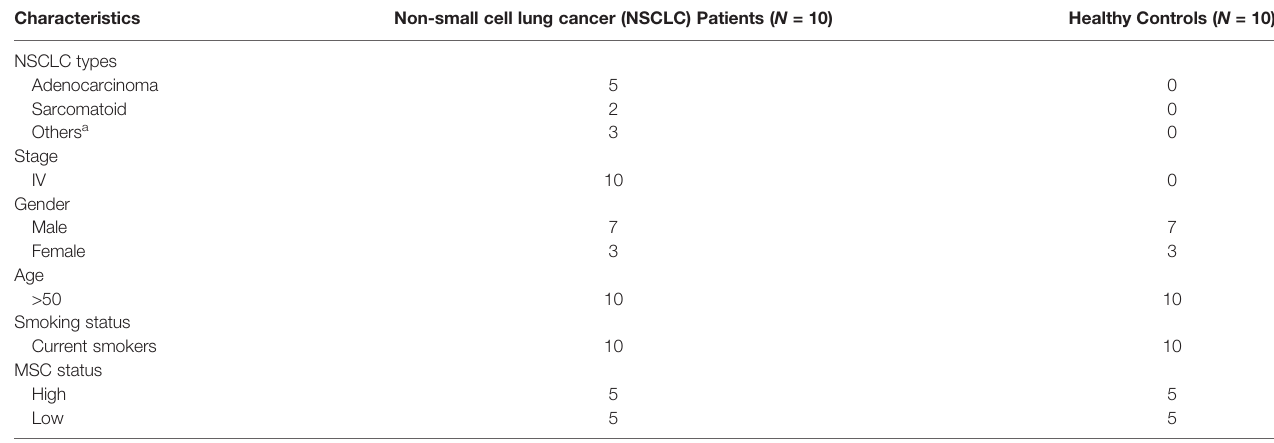
TABLE 1 | Clinicopathological features of the analyzed